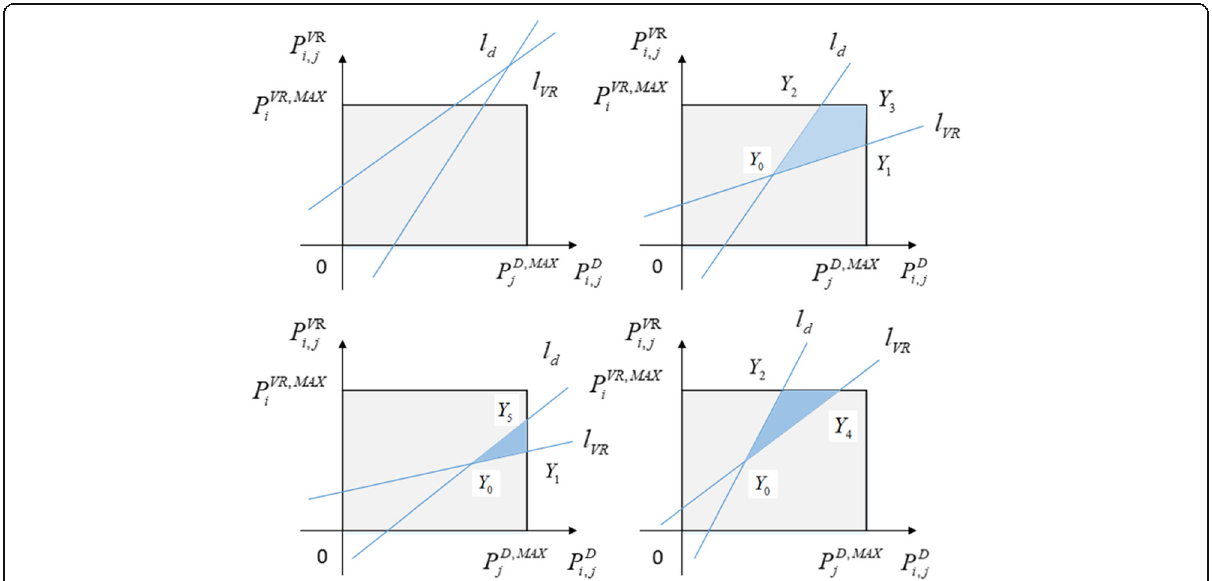
Fig. 2 Linear programming of P D and P VR power control. The figure shows the possible shape of the feasible region under different wireless i ; j i ; j channel conditions. P D ; MAX and P VR ; MAX denote the maximum transmission power of D j and VR i respectively. l vr and l d represent SINR constraints j i of transmission power for D j and VR